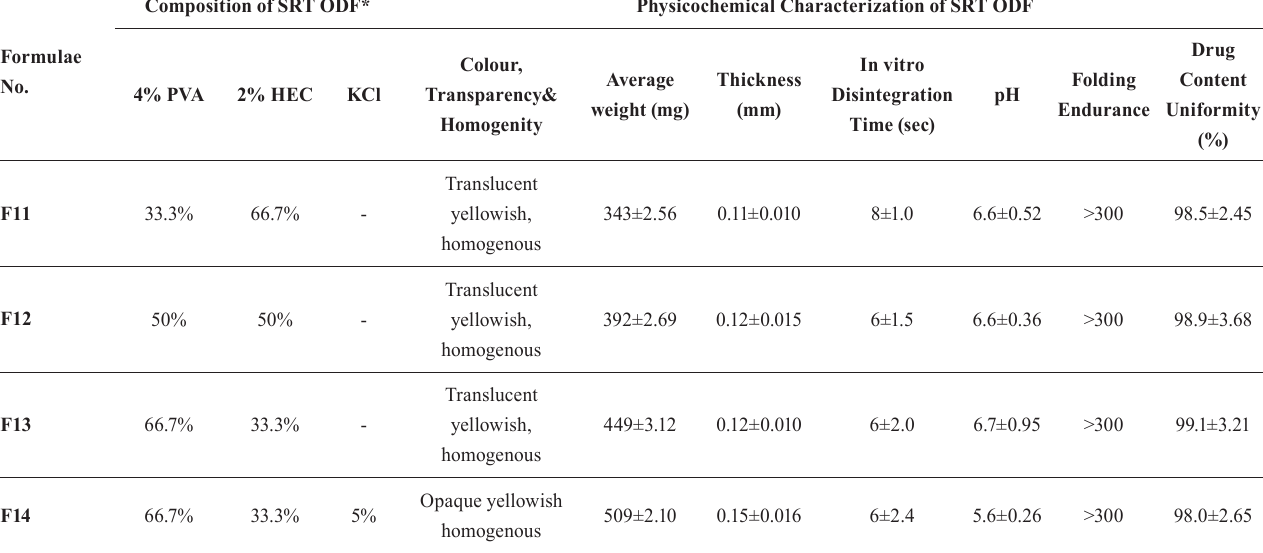
TABLE III - Composition and physicochemical characterization of optimized SRT ODFs